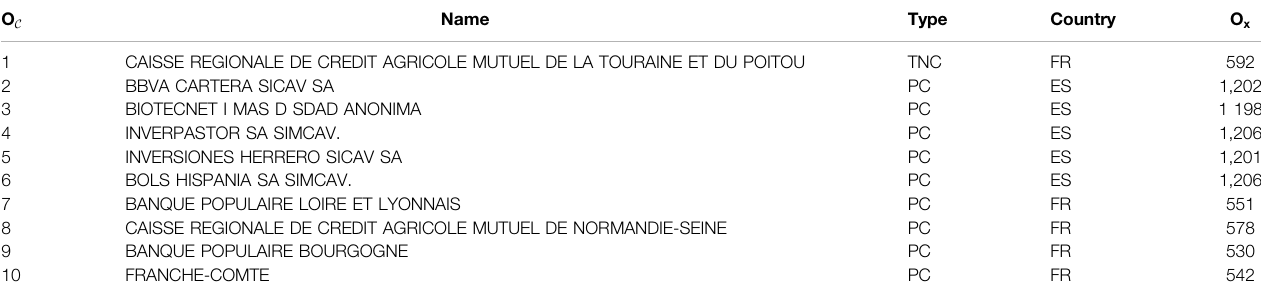
TABLE 1 | List of the fi rms that are the top 10 driver nodes ranked by their control contributions, C i . O C denotes the respective rank. O